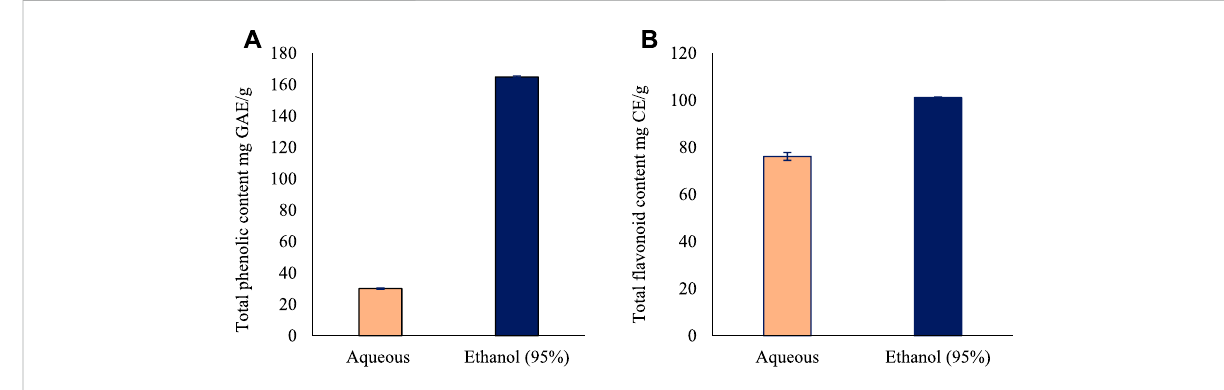
FIGURE 1 The total phenolic and fl avonoid content of the leaves extracts of Oroxylum indicum . (A) Total phenolic content in Oroxylum indicum leaf aqueous and ethanolic extracts. (B) Total fl avonoid content in Oroxylum indicum leaf aqueous and ethanolic extracts. Resultsare mean ± SD ( n =